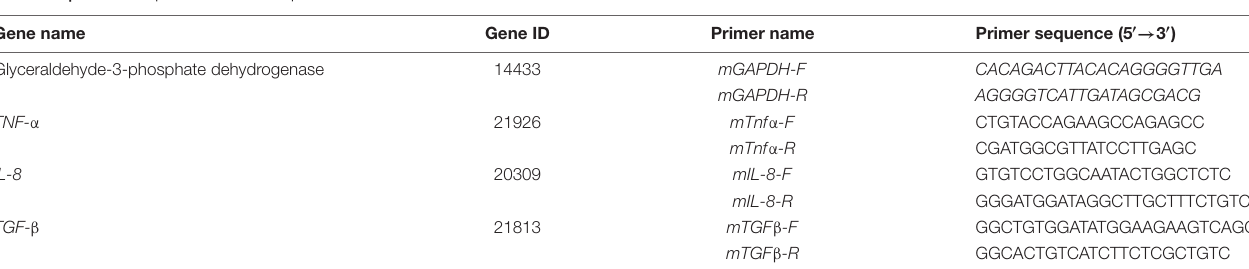
FIGURE 1 | Framework shows the experimental design of the study. TABLE 1 | Primer sequences used for